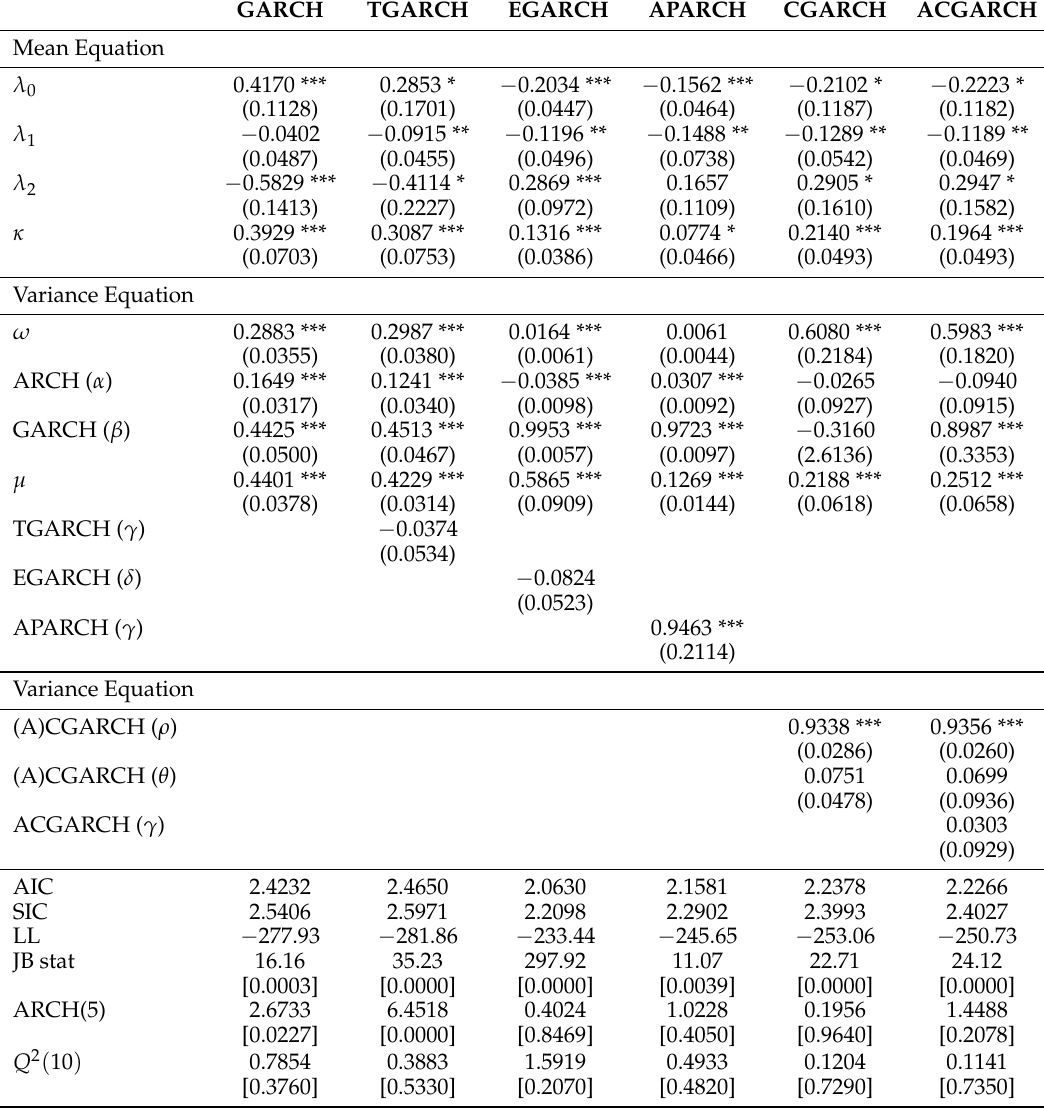
Table A10. GARCH-M Tests for Bitcoin for the recovery